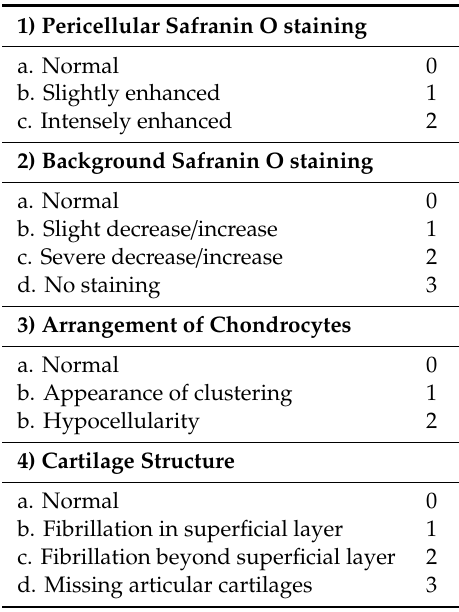
Table 1. Modified Mankin